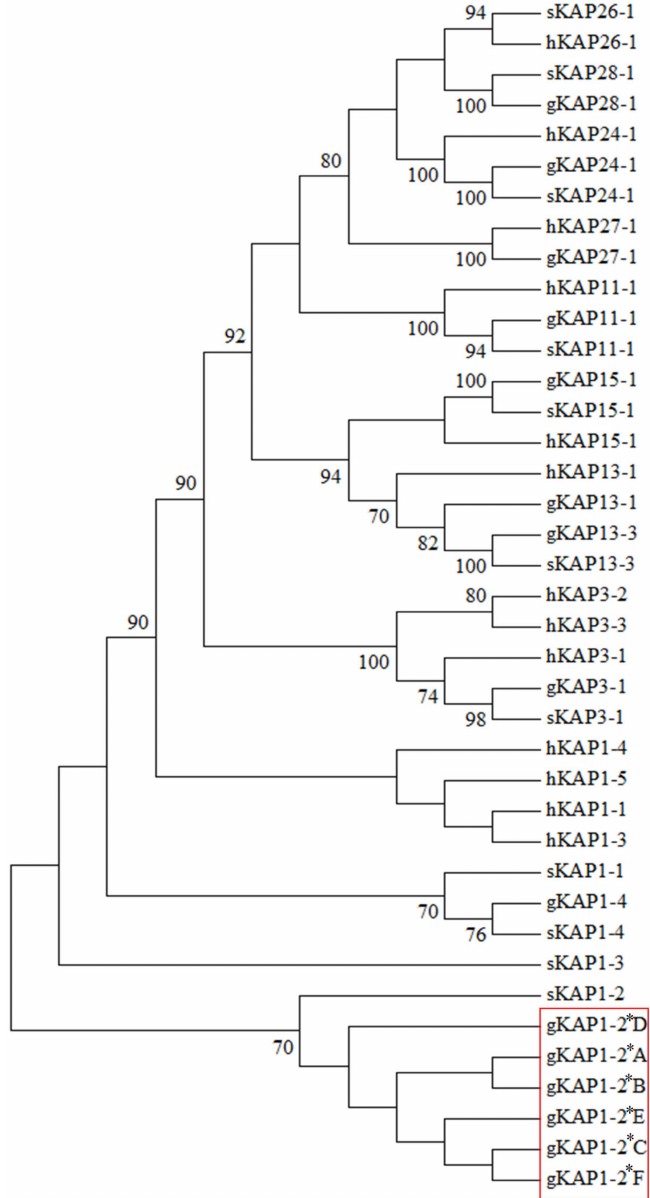
Figure 3. Phylogenetic tree of HS-KAPs identified in goats, humans and sheep. The putative amino acid sequences were used to construct the tree. The prefix “g” indicates the sequences from goats, while prefix “s” and “h” represent sequences from sheep and humans, respectively. The newly identified caprine KAP1-2 sequences are marked in a red box. The numbers at the forks represented the bootstrap confidence values with only those ≥ 70% being shown. The amino acid sequence of caprine KAP28-1 was adopted from Wang et al. [8]. The GenBank accession numbers for the other KAP sequences are: gKAP27-1 (MN934937), gKAP24-1 (MG996011),